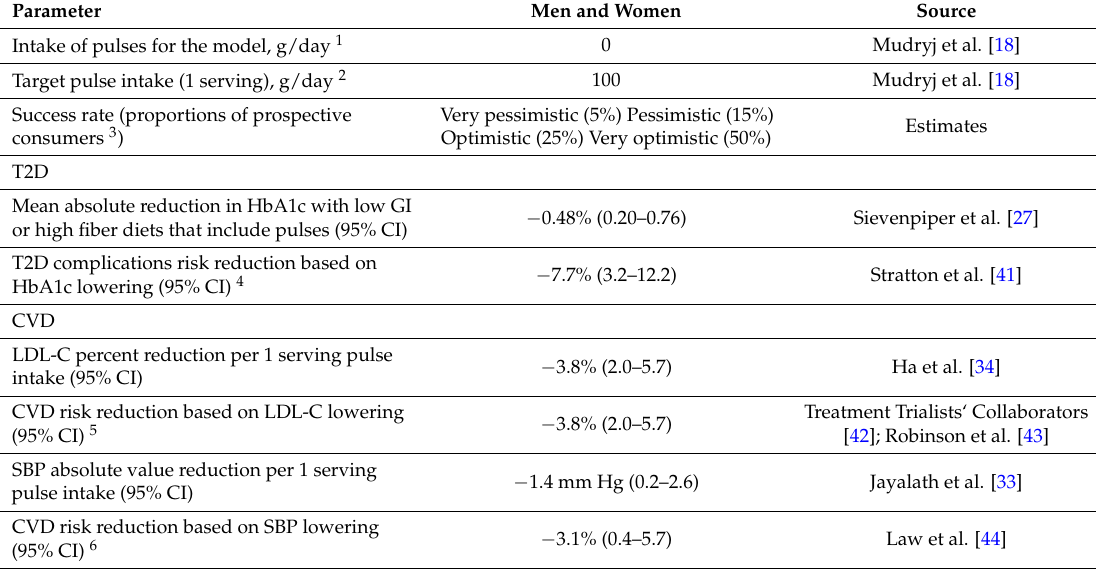
Table 1. Summary of the cost-of-illness analysis input parameters and corresponding sources.